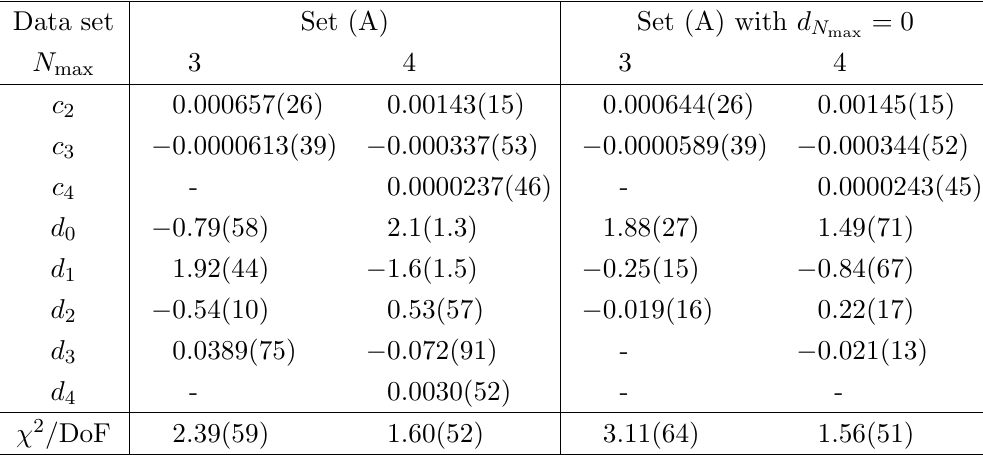
Table 2 . Fit results with the set (A) for the discrete beta function.